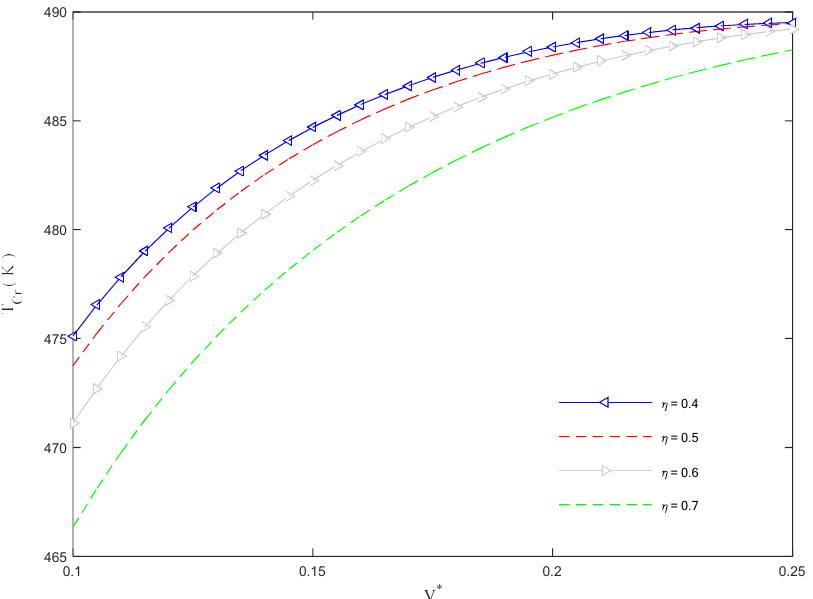
Figure 10. Critical buckling temperature versus CNTs’ volume fractions for different values of CNTs’ volume fractions inside the clusters.